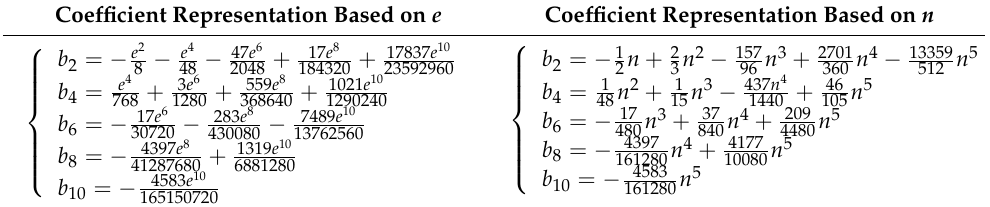
Table 2. Coefficients in Equation (6).